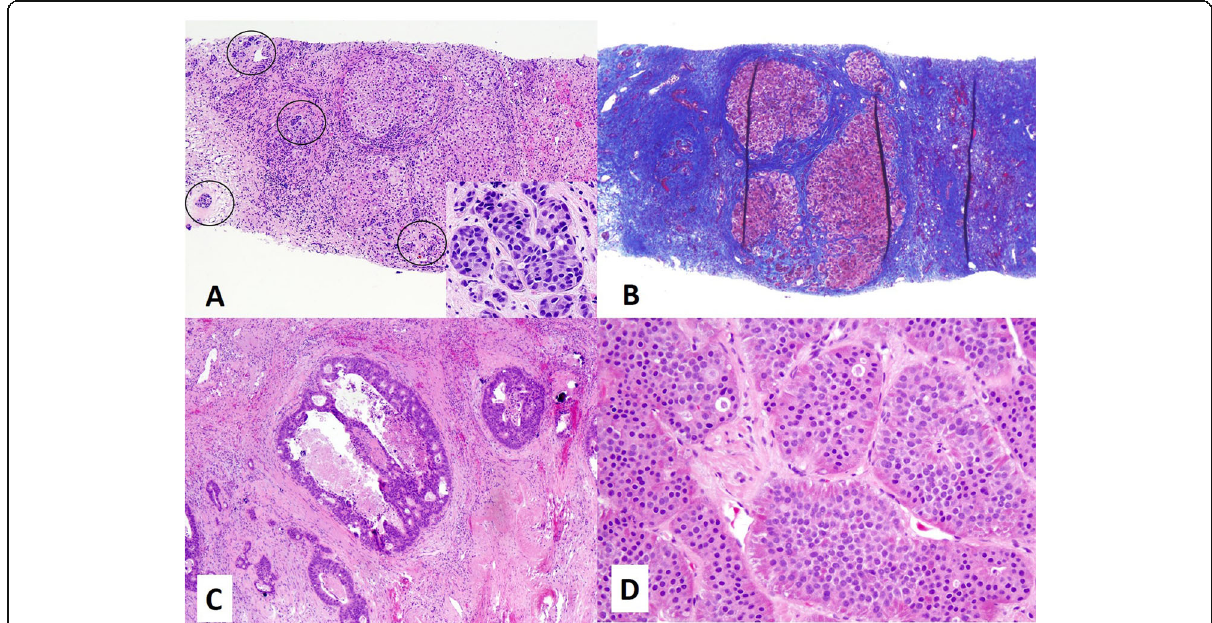
Fig. 2 Representative metastases in cirrhotic livers. a Metastatic invasive ductal carcinoma of breast, within cirrhotic parenchyma, H&E. The circled areas are the metastatic tumor cells. Inset shows a high power magnification of the carcinoma. b Trichrome stain of the case of metastatic invasive ductal carcinoma, demonstrating cirrhosis. c Metastatic colorectal adenocarcinoma, H&E. d Metastatic well-differentiated neuroendocrine tumor,